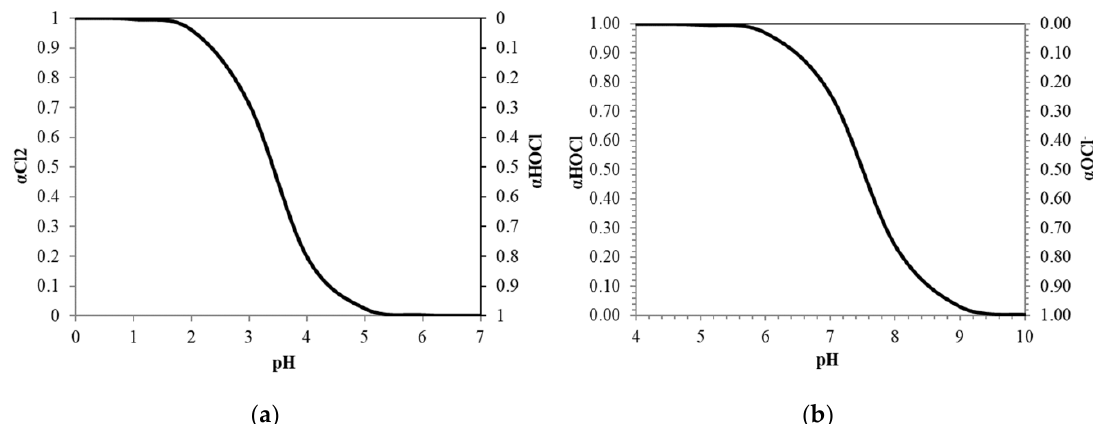
Figure 2. Distribution of ( a ) aqueous chlorine; and ( b ) hypochlorous acid in electrolyzed seawater (ESW) at different pH levels.